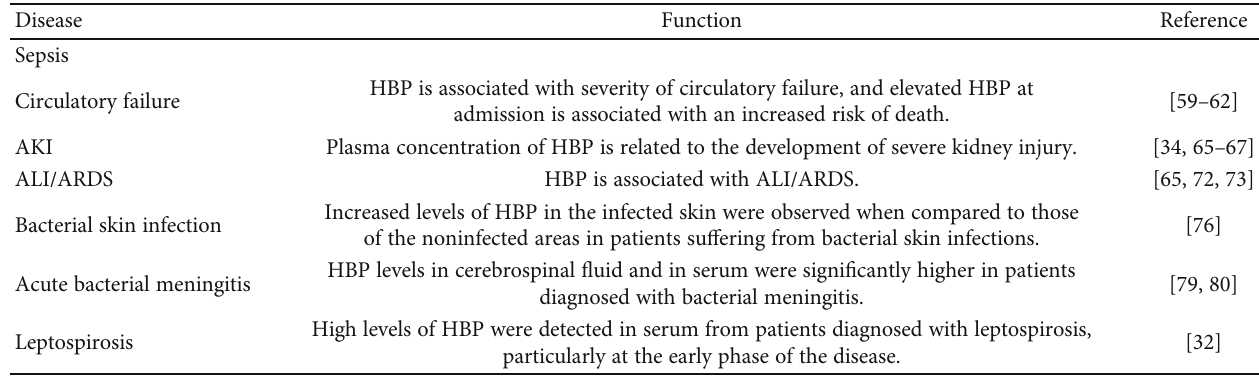
Table 2: Clinical applications of HBP for various infectious